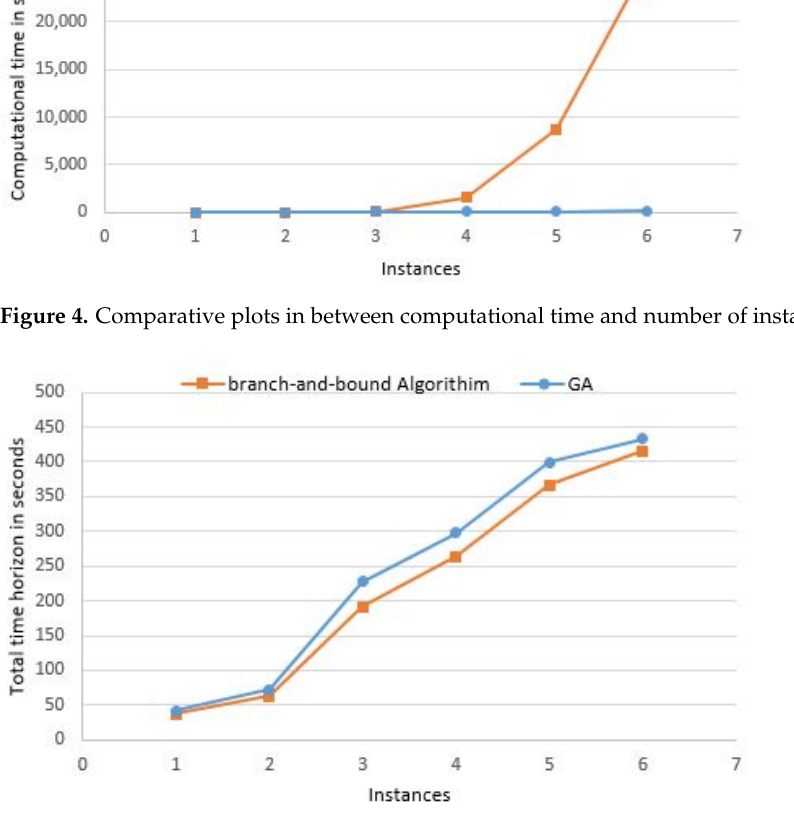
Figure 5. Comparative plots in between total time horizon and number of instances.